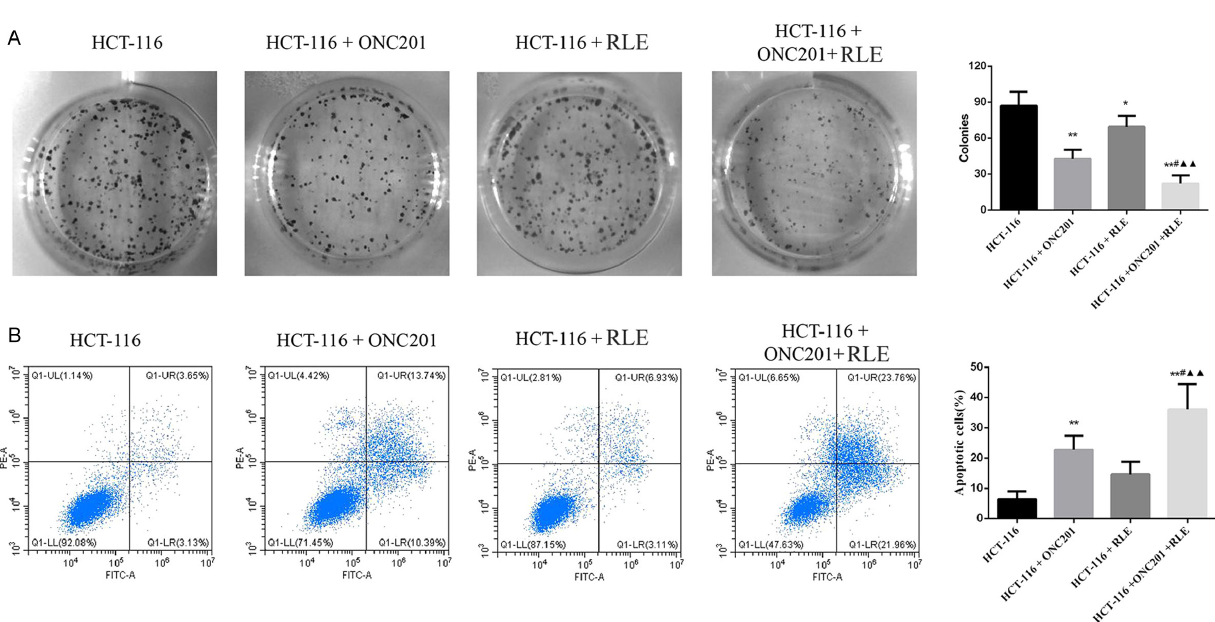
Figure 2. RLE inhibits HCT116 cell growth and facilitates ONC201 induced HCT116 cell apoptosis. (A) Colony formation assays were performed to detect cell growth. (B) Annexin V/PI staining assays were performed to assess cell apoptosis. * P < .05, ** P < .01 versus the HCT116 group; # P < .05, ## P < .01 versus the HCT116 + ONC201 group; ▲ P < .05, ▲▲ P < .01 versus the HCT116 + RLE group. RLE, raw lacquer extract.